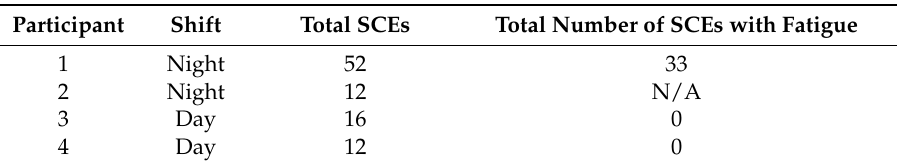
Table 3. Summary of actigraph data collected.